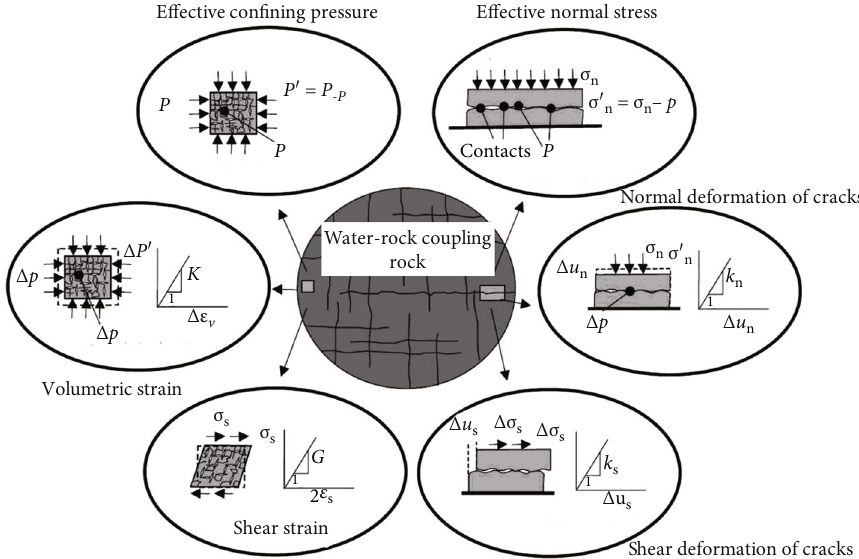
Figure 1: Deformation characteristics of rock mass under hydraulic